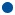
Spatial and temporal analysis of the antimony susceptibility of Leishmania isolates from Algeria during 1994 to 2013.Antimony (SbIII) susceptibility of Leishmania isolates according to the 3 biogeographic areas (A). Antimony (SbIII) susceptibility of Leishmania isolates causing VL (B) or CL (C) according to the three decades, beginning in 1994. Evolution of the frequency of S- phenotype Leishmania isolates during the three last decades (D). L. infantum (●), L major (●), and L. killicki (●).